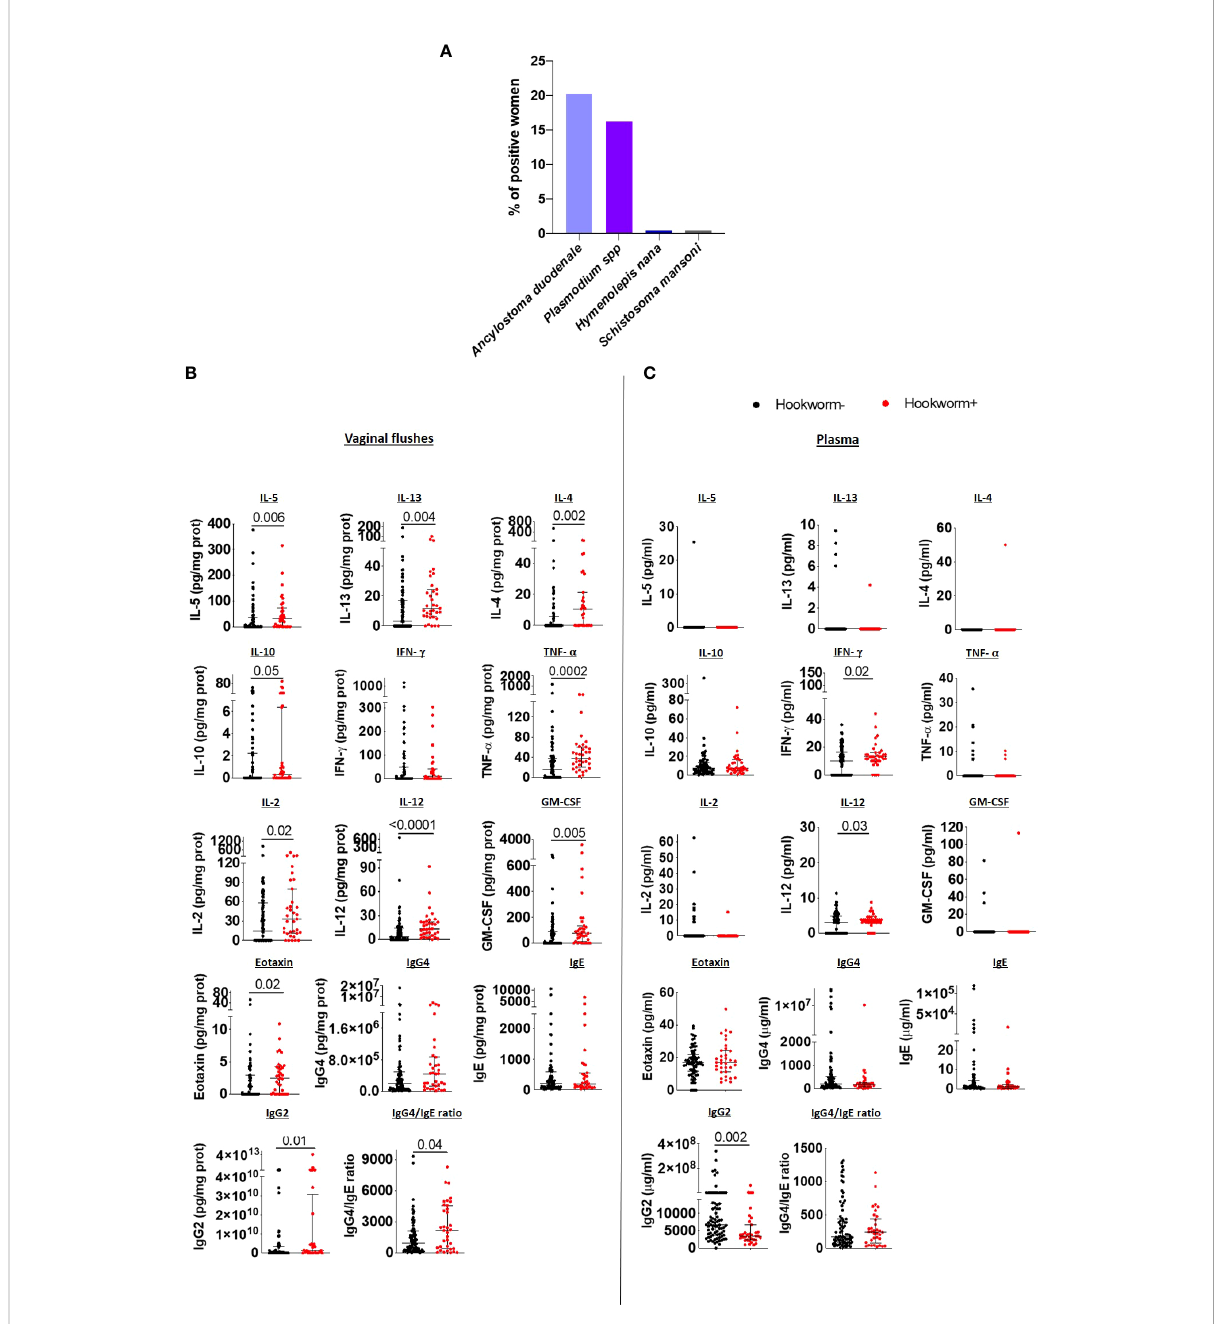
FIGURE 2 Hookworm infection induces a mixed Type 1/Type 2 immune response in the FRT. (A) Overview of parasite infection in the cohort (n=203). Each bar represents the total percentage of women in each category of infection. IL-5, IL-13, IL-4, IL-10, IFN- g , TNF- a , IL-2, IL-12, GM-CSF, eotaxin, IgG4, IgE and IgG2 levels, and the IgG4/IgE ratio in the vaginal fl ushes (B) and plasma (C) of hookworm- and hookworm+ women. Each dot represents a single individual, horizontal bars indicate the median and IQR. To normalize VF data, individual analyte concentrations were expressed as ratio of the measured parameter and the total protein concentration of the sample. Hookworm- (n=78) hookworm+ (n=35). A Mann Whitney U test was used to compare hookworm- and hookworm+